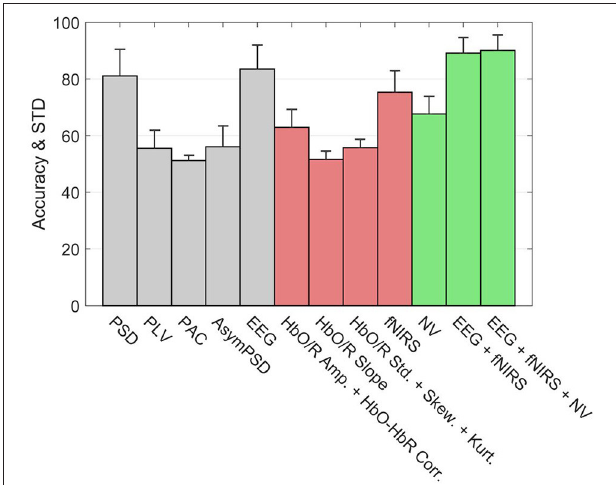
FIGURE 10 | Accuracy of types of features in classifying rest v 3-back with 5 s feature windows. The error bars indicate the standard deviation of inter-subject variability. The union of neurovascular features is abbreviated as NV. Features are extracted from different systems: EEG (gray bars), fNIRS (red bars), and Hybrid (green bars).